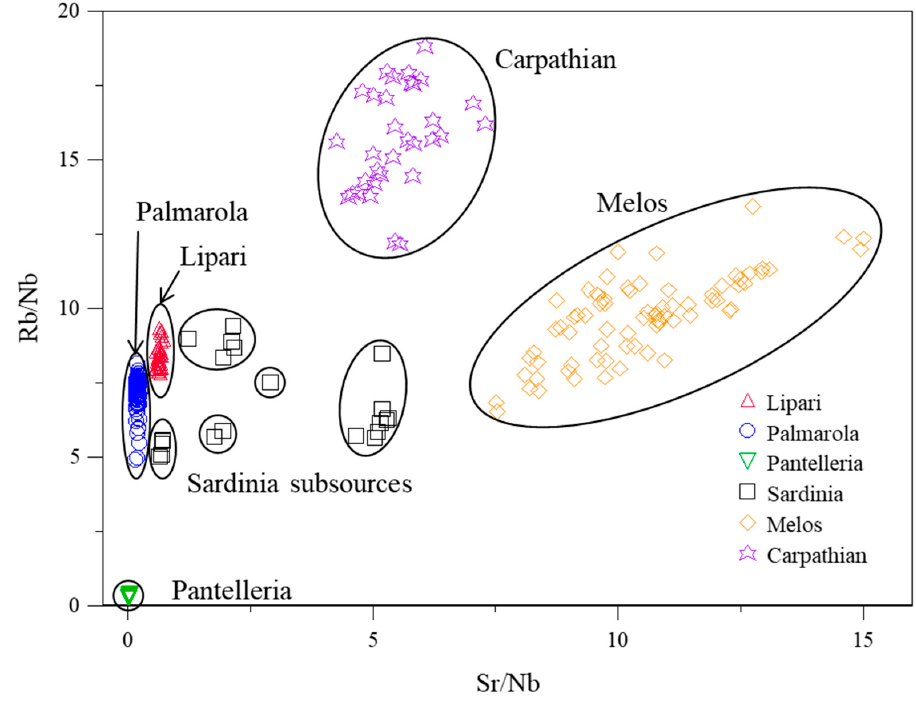
Figure 6. Distinguishing European obsidian sources with selected trace elements. Not all geological samples tested are shown.